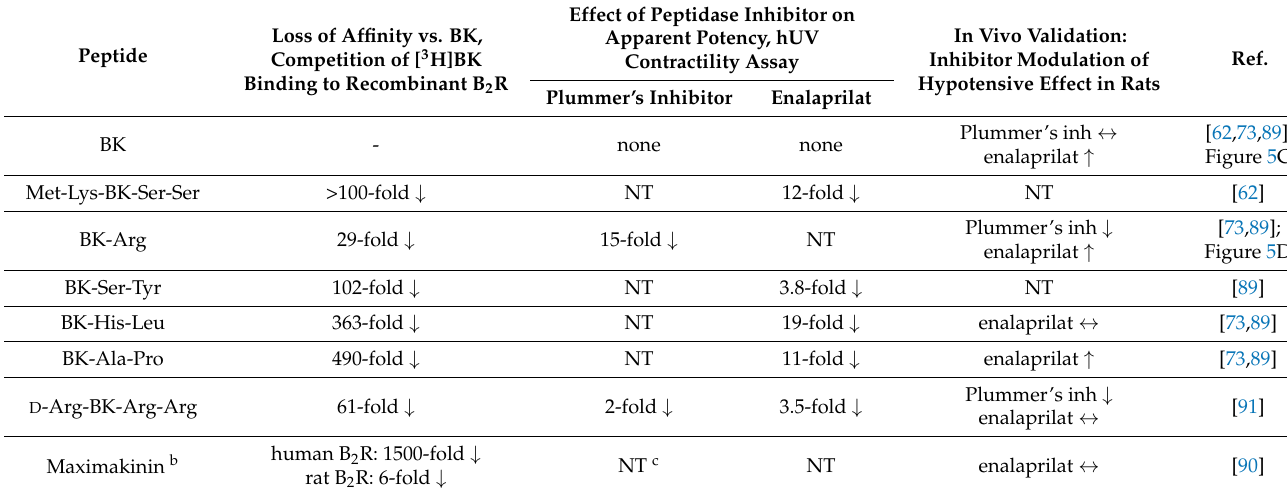
Table 2. Latent agonists of the B 2 R that contain the BK sequence evaluated using the umbilical vein contractility assay a . Effect of Peptidase Inhibitor on Loss of Affinity vs. BK, In Vivo Validation: Apparent Potency, hUV Peptide Competition of [ 3 H]BK Inhibitor Modulation of Contractility Assay Binding to Recombinant B 2 R Hypotensive Effect in Rats